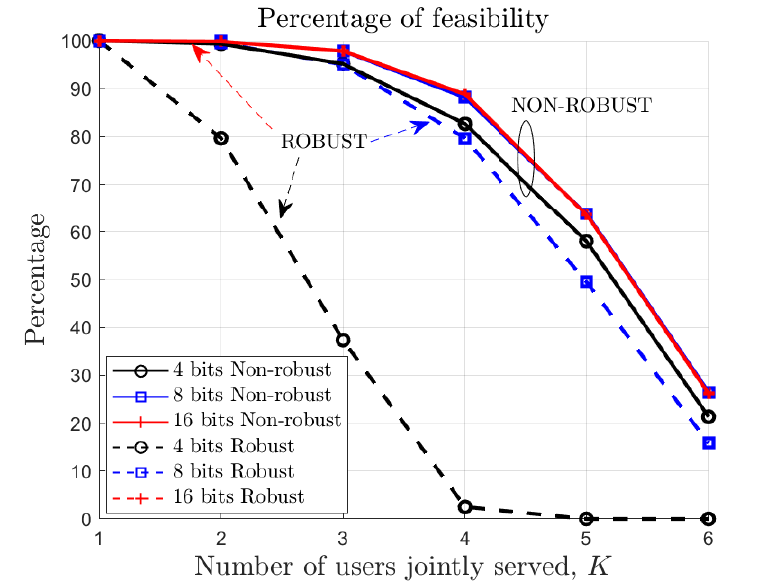
Figure 2. Percentage of successful designs (averaged over different channel realizations) for different numbers of jointly served users and quantization